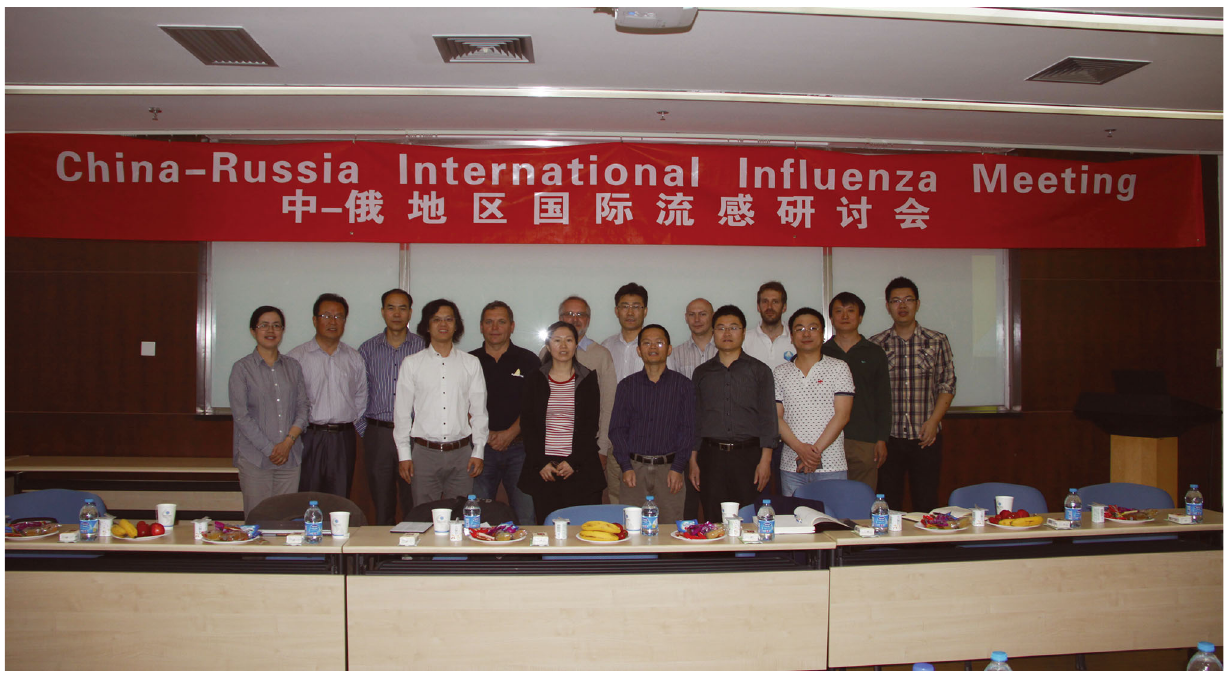
Figure 1. A joint meeting between China and Russia on in fl uenza research held at the Institute of Microbiology, Chinese Academy of Sciences in Beijing in 2014.